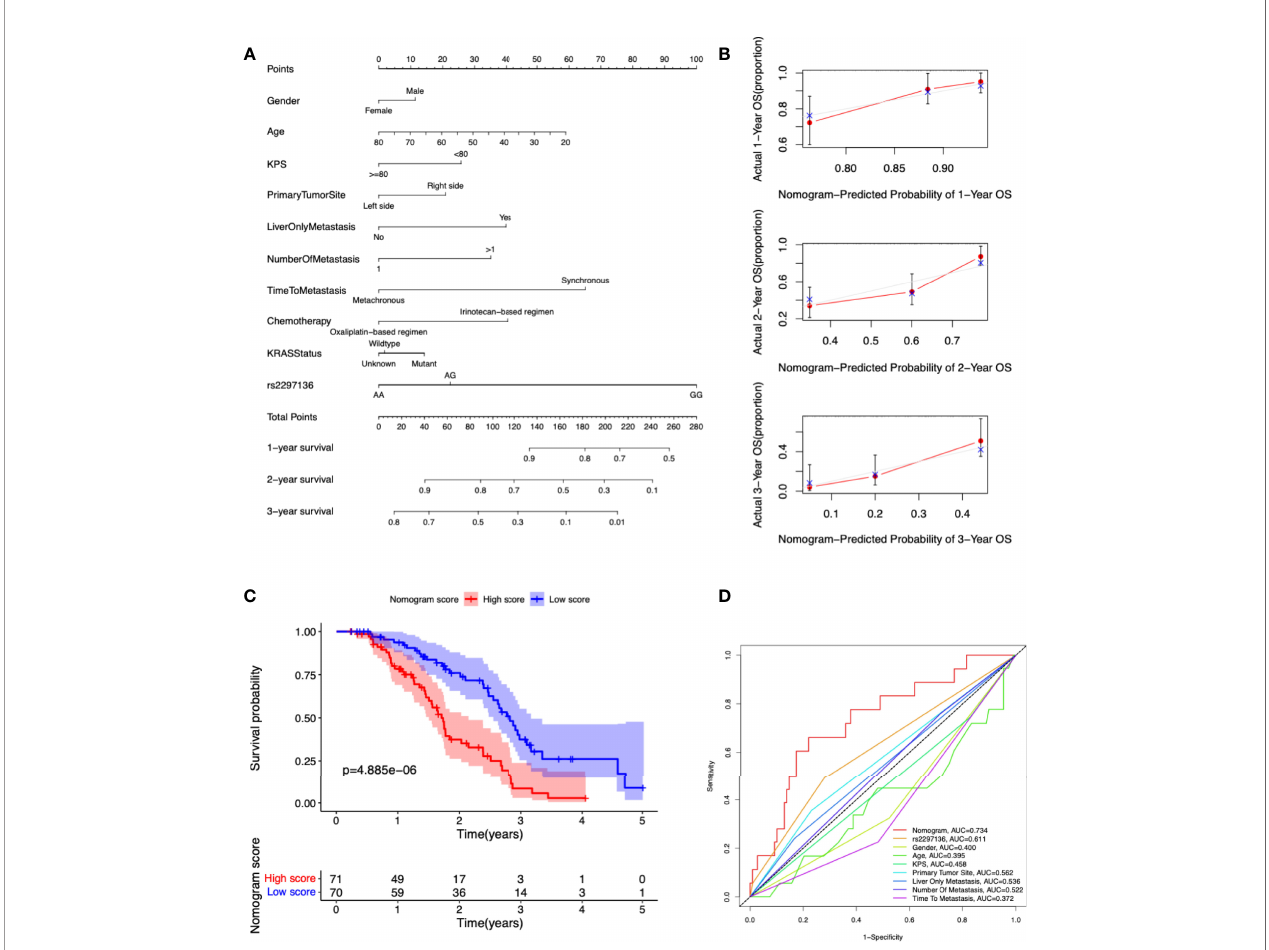
FIGURE 3 | Development and validation a nomogram for predicting prognosis of mCRC patients treated with bevacizumab-based chemotherapy. (A) A nomogram was constructed to predict 1-, 2-, 3-year OS. (B) Calibration plots of the nomogram for 1-, 2-, 3-year OS. (C) Kaplan-Meier curves of OS based on the nomogram scores. (D) The ROC curves of nomogram score, rs2297136 and other clinical